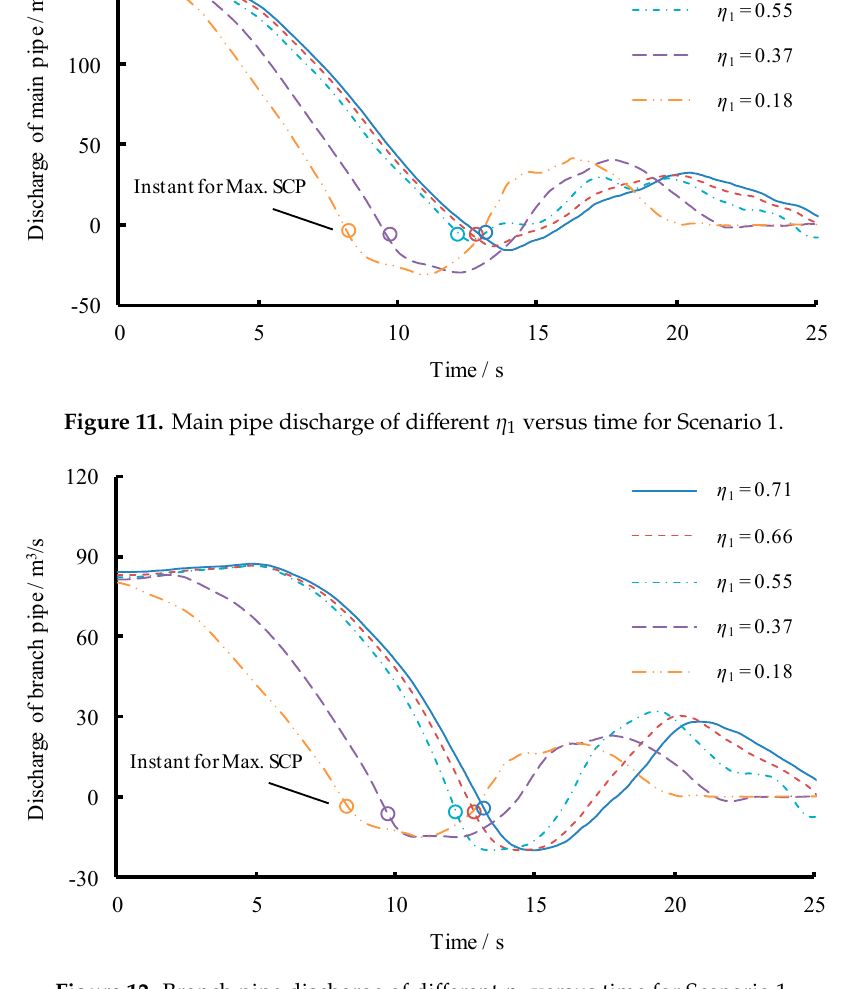
Figure 12. Branch pipe discharge of different η 1 versus time for Scenario 1.